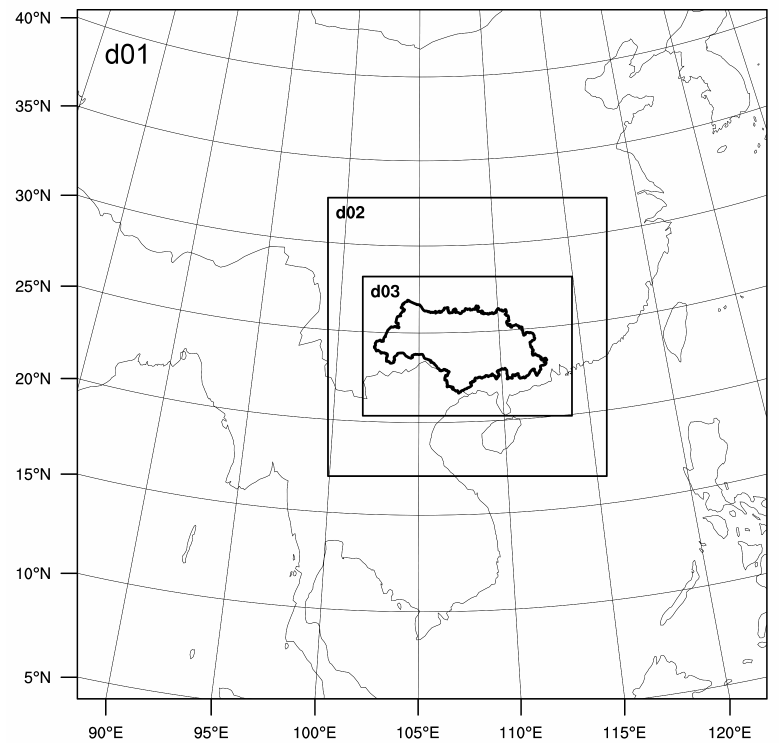
Figure 3. Map of domain sizes of the d01–d03